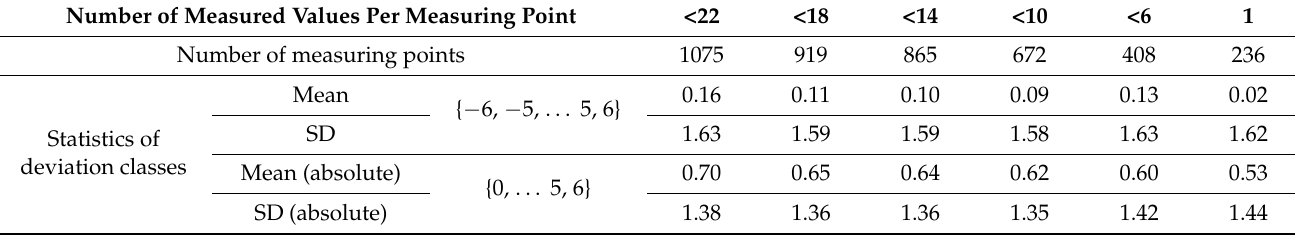
Table 3. Statistics of “deviation classes” (difference of classified average simulated nitrate concentration in leachate and classified median of measured nitrate concentration in groundwater) and frequency of successively decreasing numbers of measured values per measuring